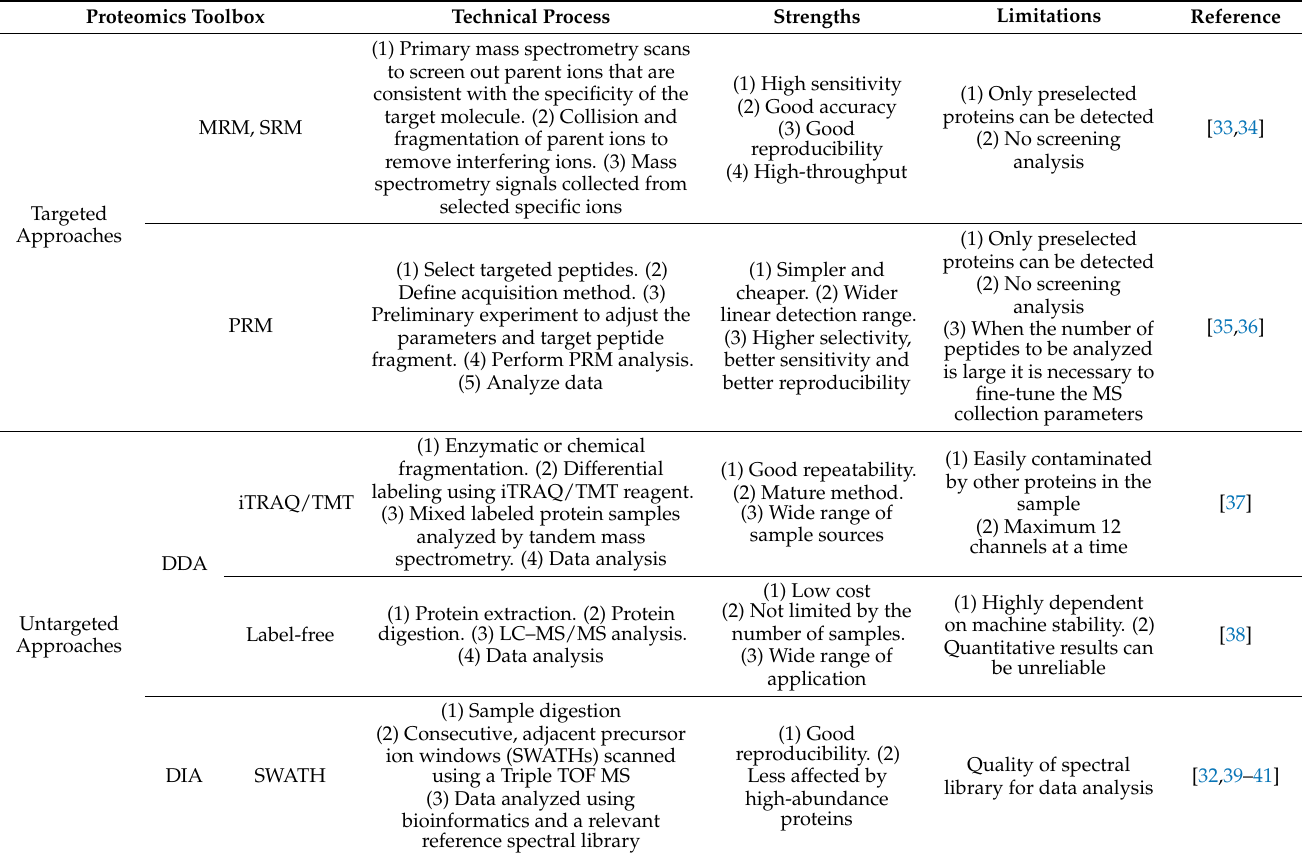
Table 1. Proteomics